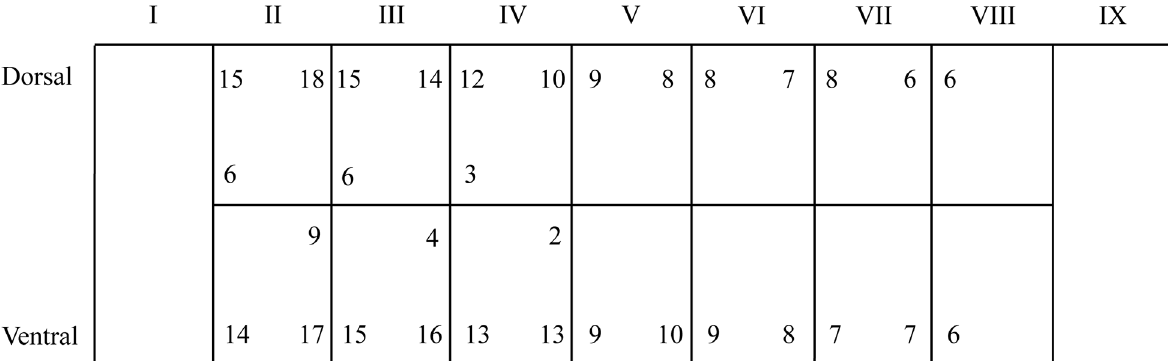
Figure 4. Position and number of branches (arabic numerals) of abdominal tracheal gills in the larva of the caddisfly Verger lutzi . I-IX: number of